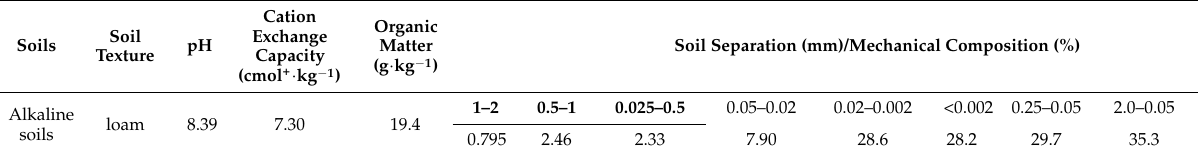
Table 1. Analytical data of soils.